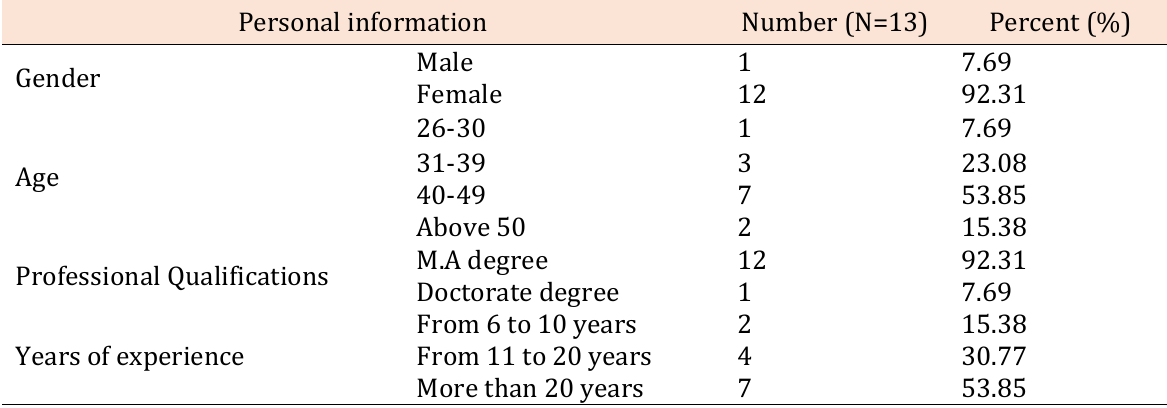
Table 1. Summary of the personal information of participants for the questionnaire